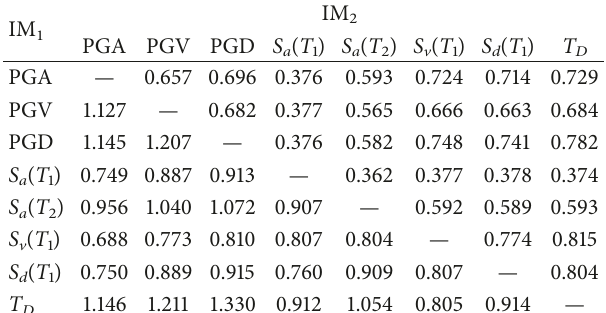
� < IM � S c ) as a function of vector IM 1 a ( T 1 ), IM 2 > using multiple linear regression on the 3D cloud data: Table 5: Dispersion of EDP | IM 1 ,IM 2 . The upper and lower tri- angles show the dispersion values for EDP as DI base and DI neck ,